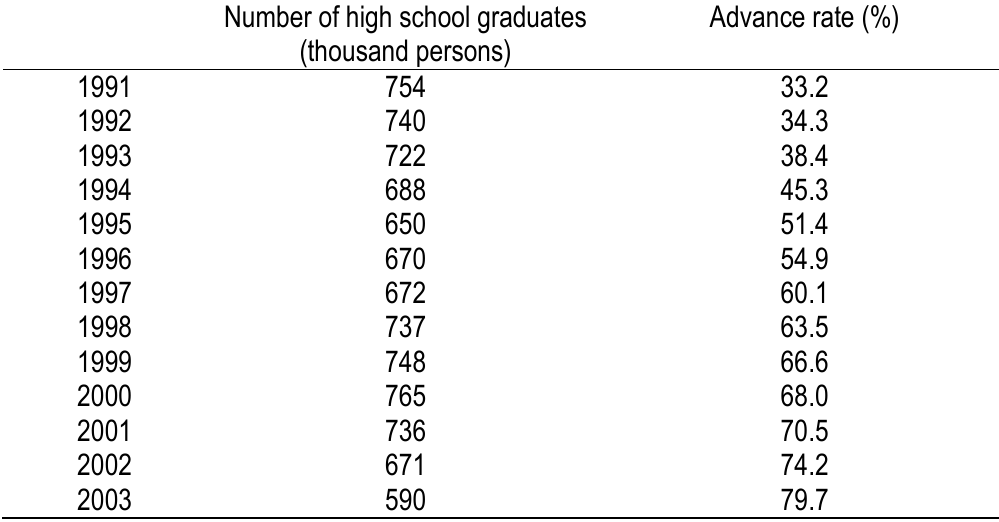
Table 9. Number of high school graduates and their advance rates to higher education level Number of high school